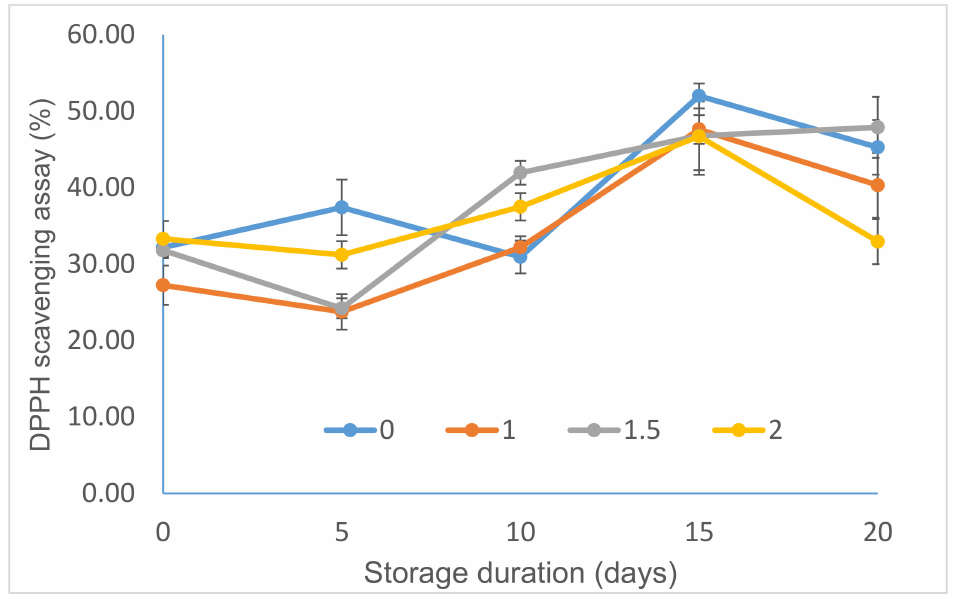
Figure 9. The interaction effects of CaCl 2 (0, 1, 1.5, and 2%) and storage durations (0, 5, 10, 15, and 20 days) on DPPH scavenging activity (%) of tomato fruit stored at ambient temperature (28 ± 2 ◦ C and 75 ± 5% RH). Vertical bars indicate the standard error of means for 4